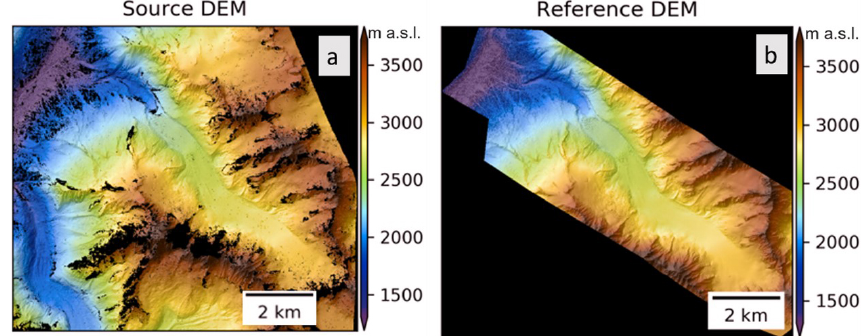
Figure 3. (a) The source Pleiades DEM used for further analysis; (b) the reference lidar DEM of the Argentière glacier used for co-